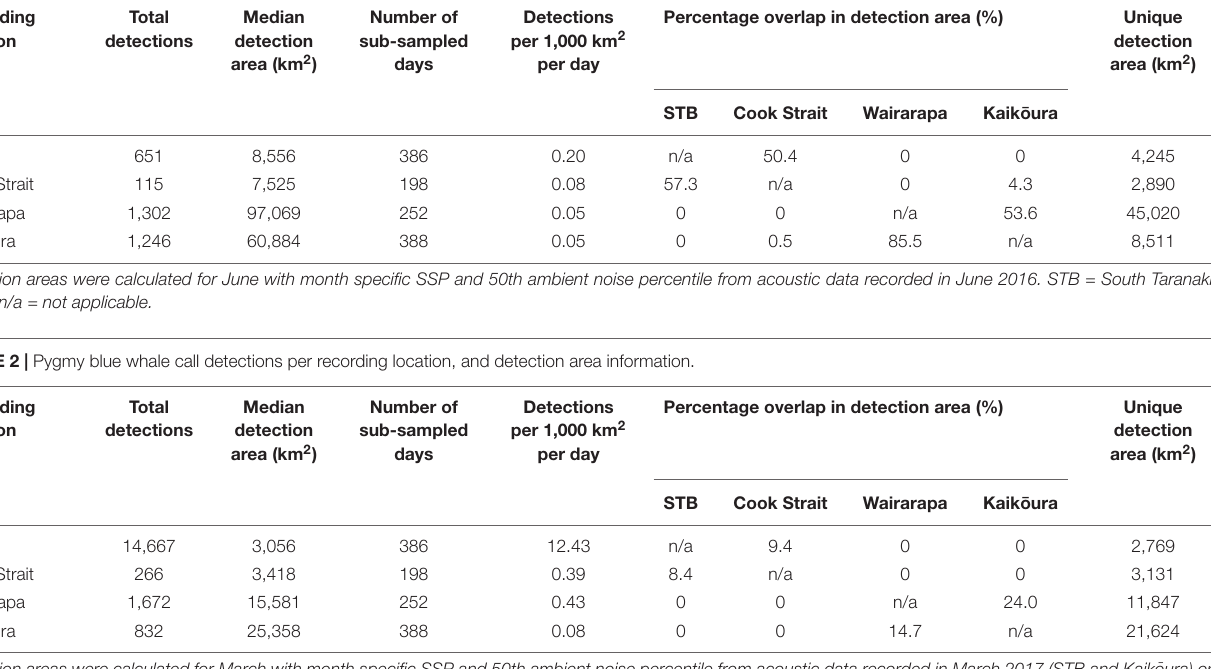
TABLE 1 | Antarctic blue whale call detections per recording location, and detection area information. Recording location